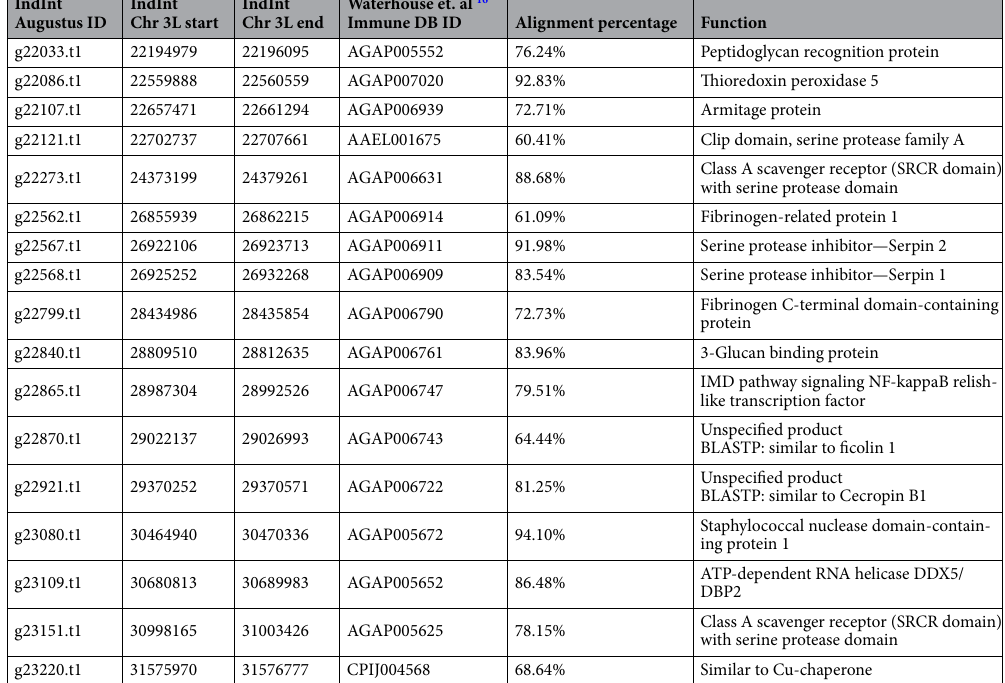
Table 2. Genes within the 3Li region of IndInt that are reported to be implicated in immune response by Waterhouse et al. 16